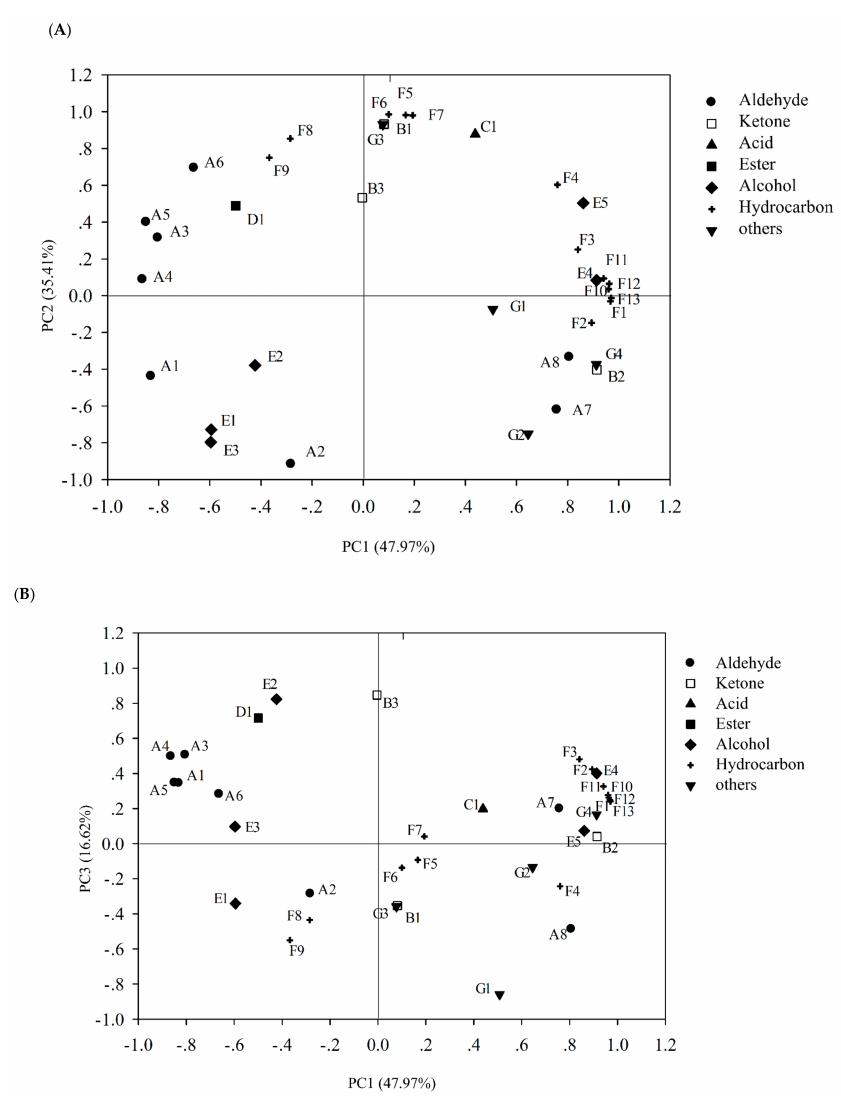
Figure 5. Variable loadings on plane1-2 ( A ) and 1-3 ( B ) of principle component analysis (PCA) on volatile